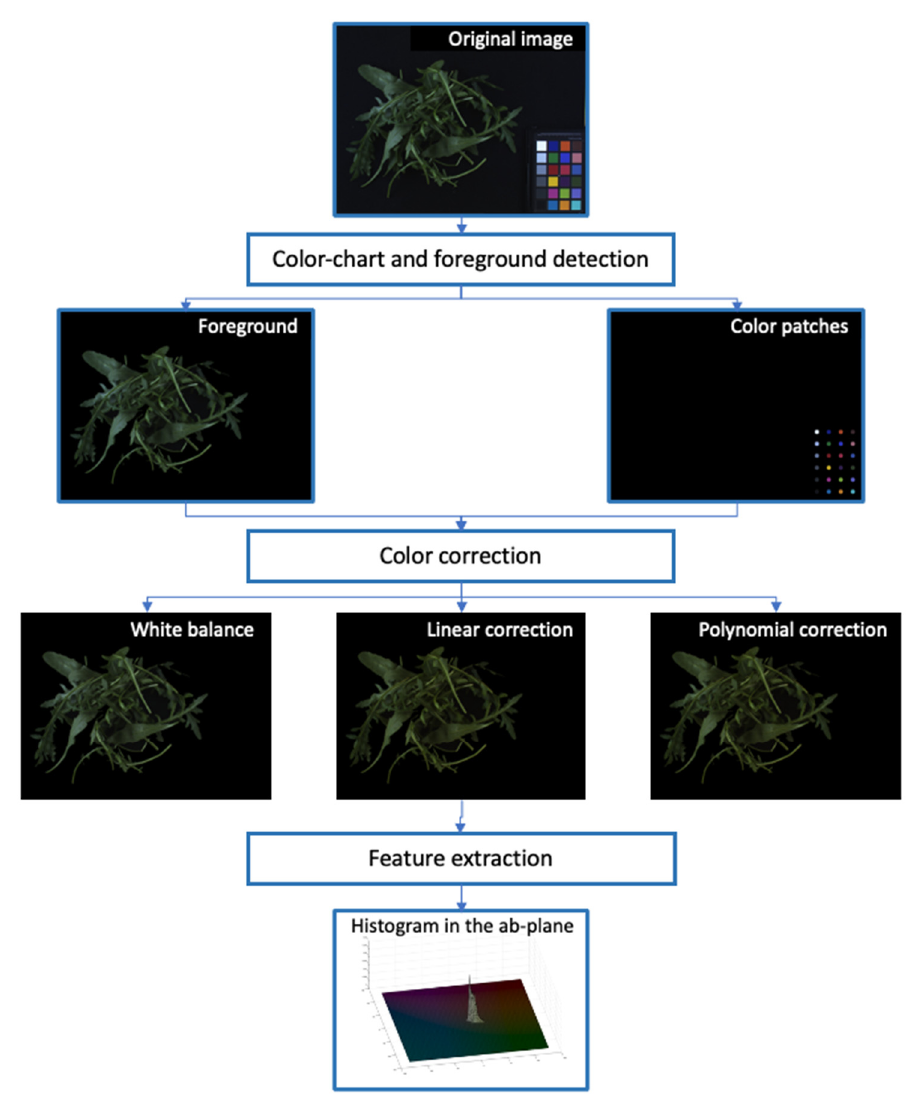
Figure 2. The figure shows the flow chart of the processing done on the images. It is possible to appreciate the effects of each step on the input image and the results provided to the following steps. Data extracted from the patches of the color chart have been used to evaluate the parameters of the three different correction models compared. For each of them, a histogram was evaluated, such as the one shown for the linear model, which provides the best trade-off between efficacy and computational complexity.